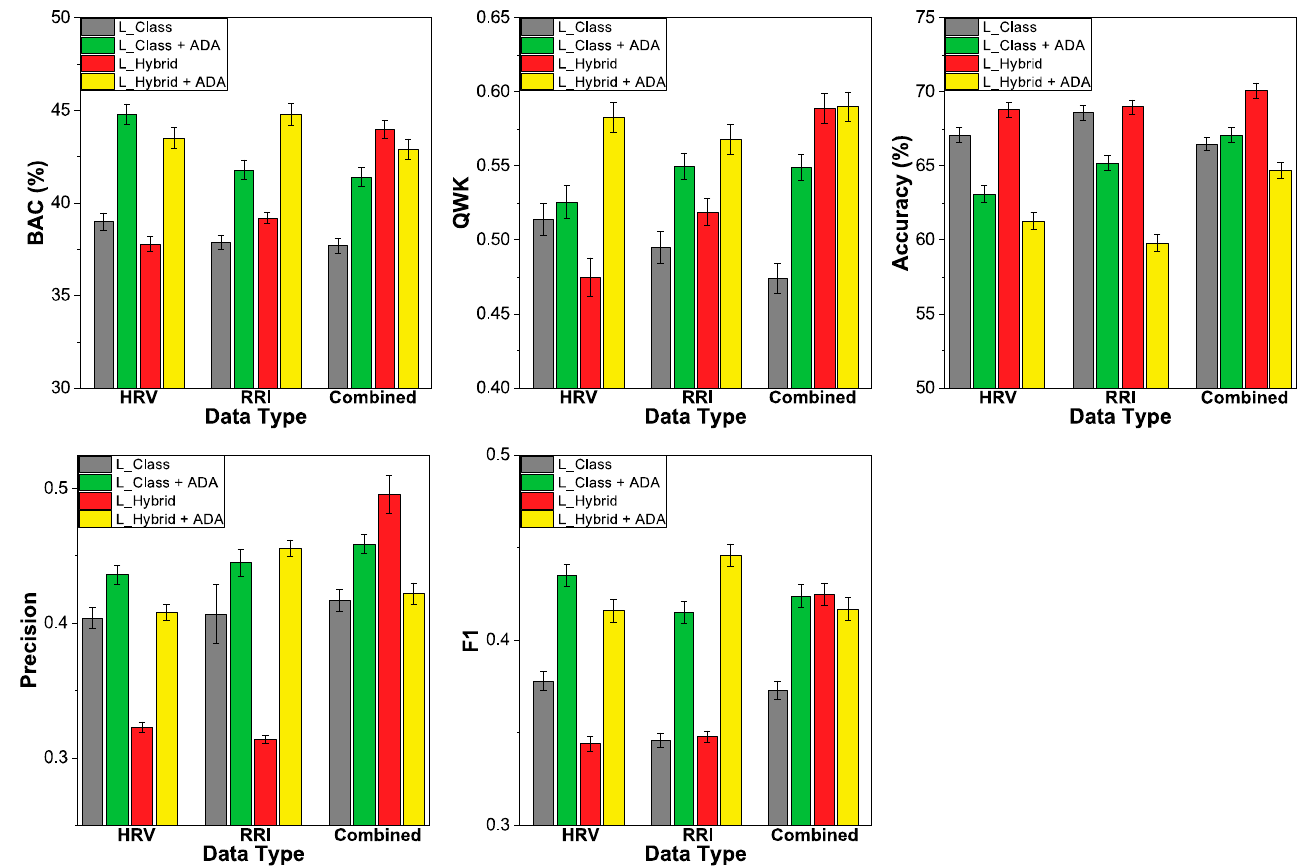
Figure 5. Mean and 95% CI (error bars) of the prediction performance based on the data type and method. L_Class: classification loss; L_Hybrid: hybrid loss; ADA: Table 7. Mean prediction performance for each age group based on the data type and method.